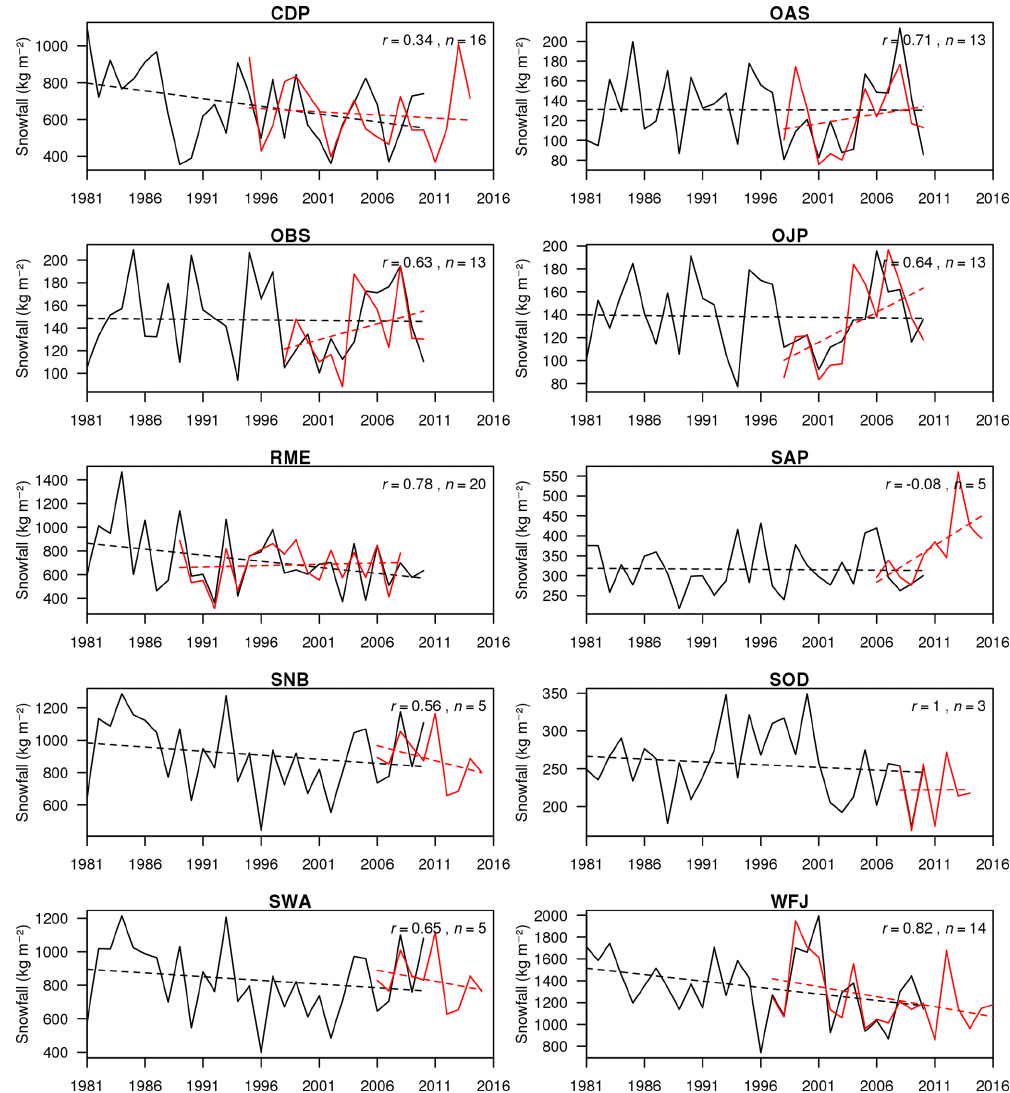
Figure 11. Annual snowfall and fitted trends for years starting on 1 October at reference sites from GSWP3 and in situ data. Numbers show correlation ( r ) between GSWP3 and in situ snowfall for the n complete years of overlap. The legend is as in Fig.